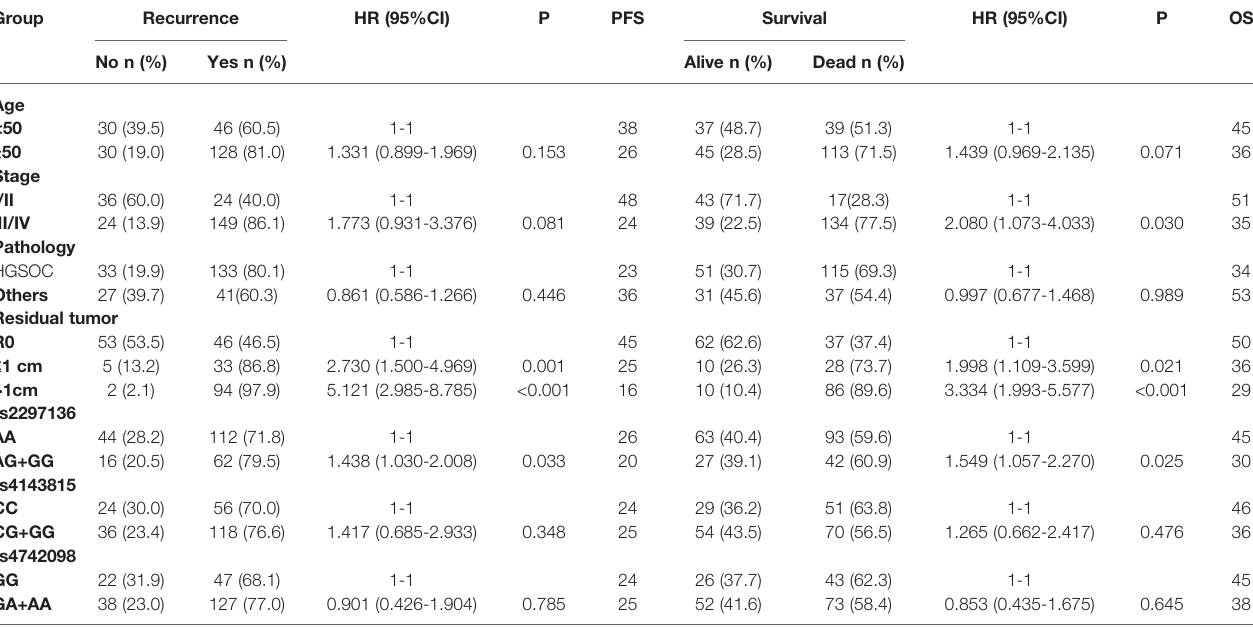
TABLE 4 | Univariate analysis of prognostic factors for 5-year progression-free survival and overall survival of EOC